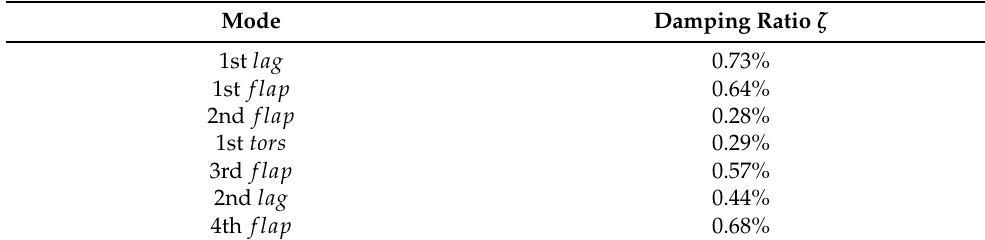
Table 11. BO105 MR blade damping ratio at 1050 rpm.